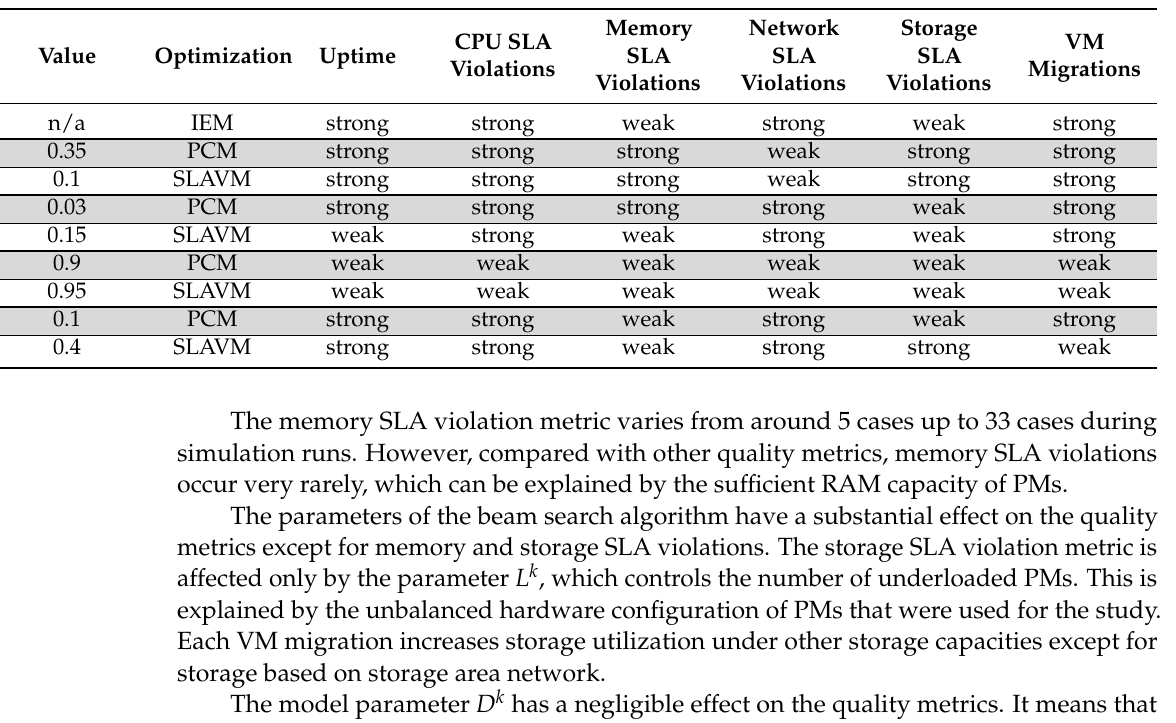
Table 4. The influence of the model parameters on the quality